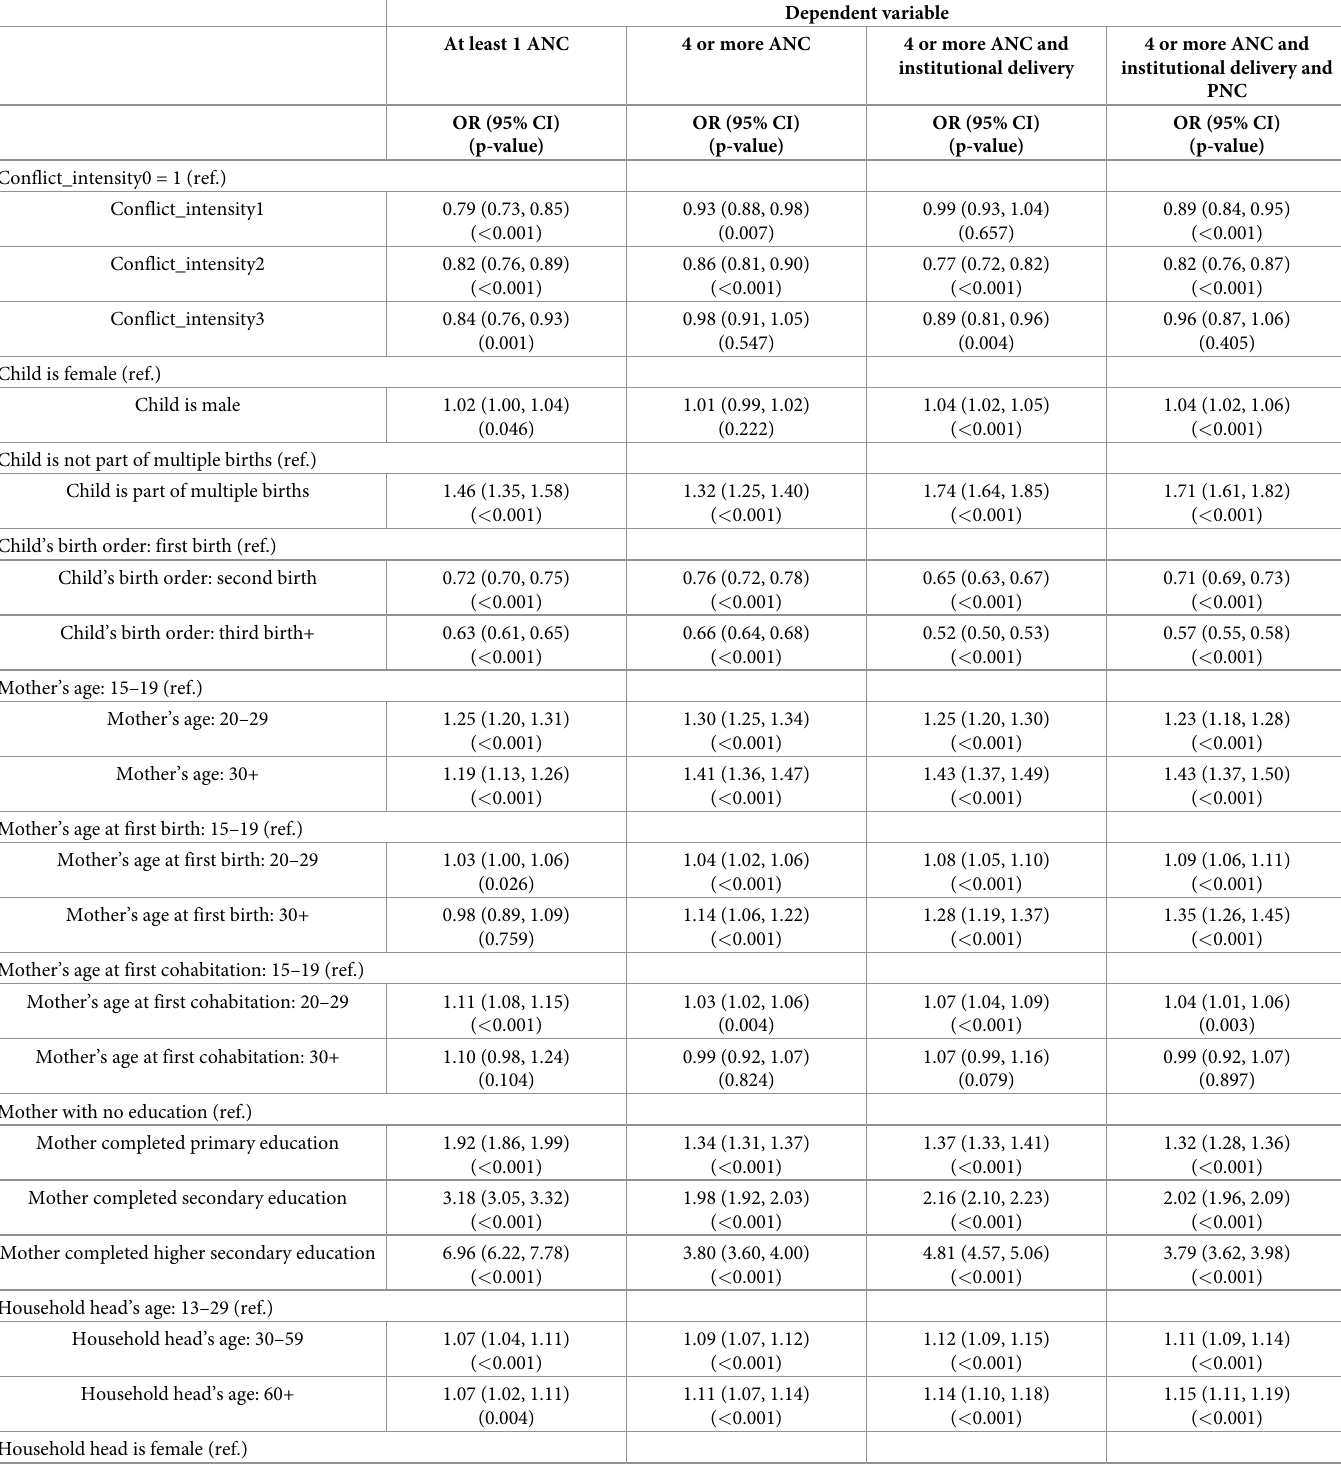
Table 5. Associations between intensity of exposure to conflict and